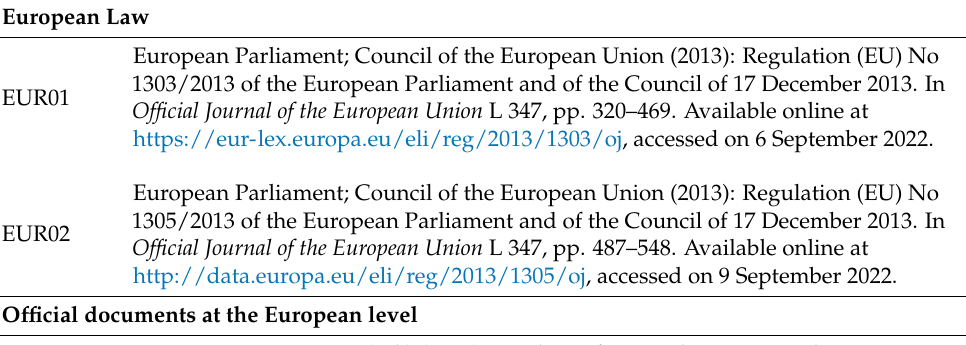
Table A1. Overview and description of data collected for the